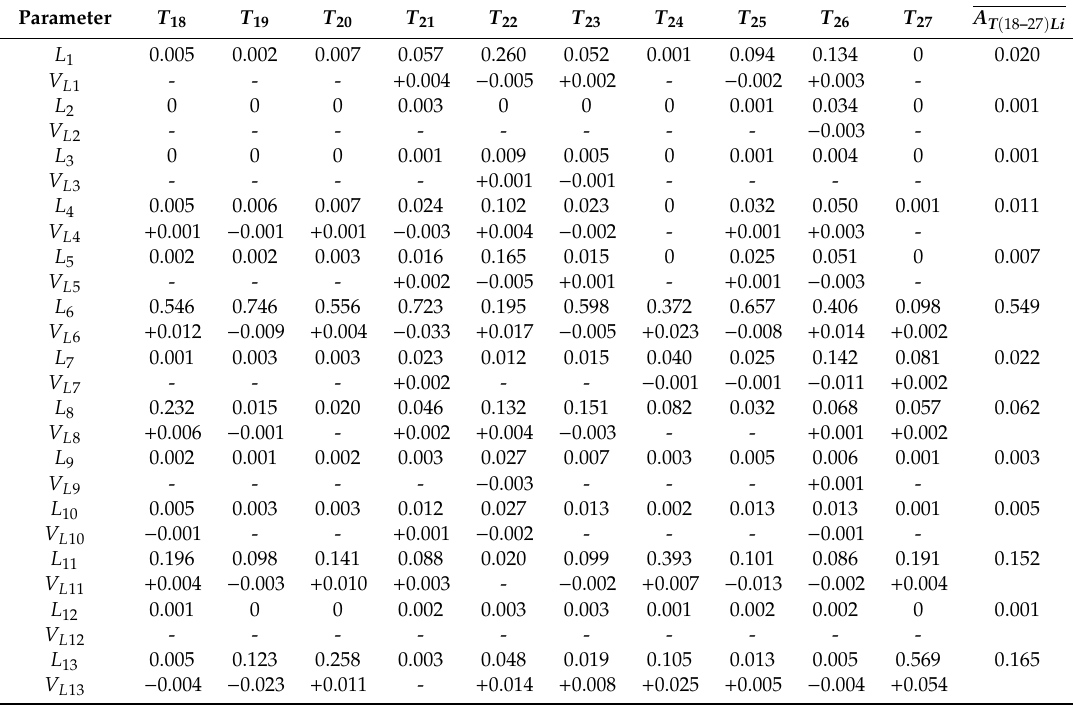
Table A10. Activity per land category in Russia, Northwestern Federal District. Mean values for